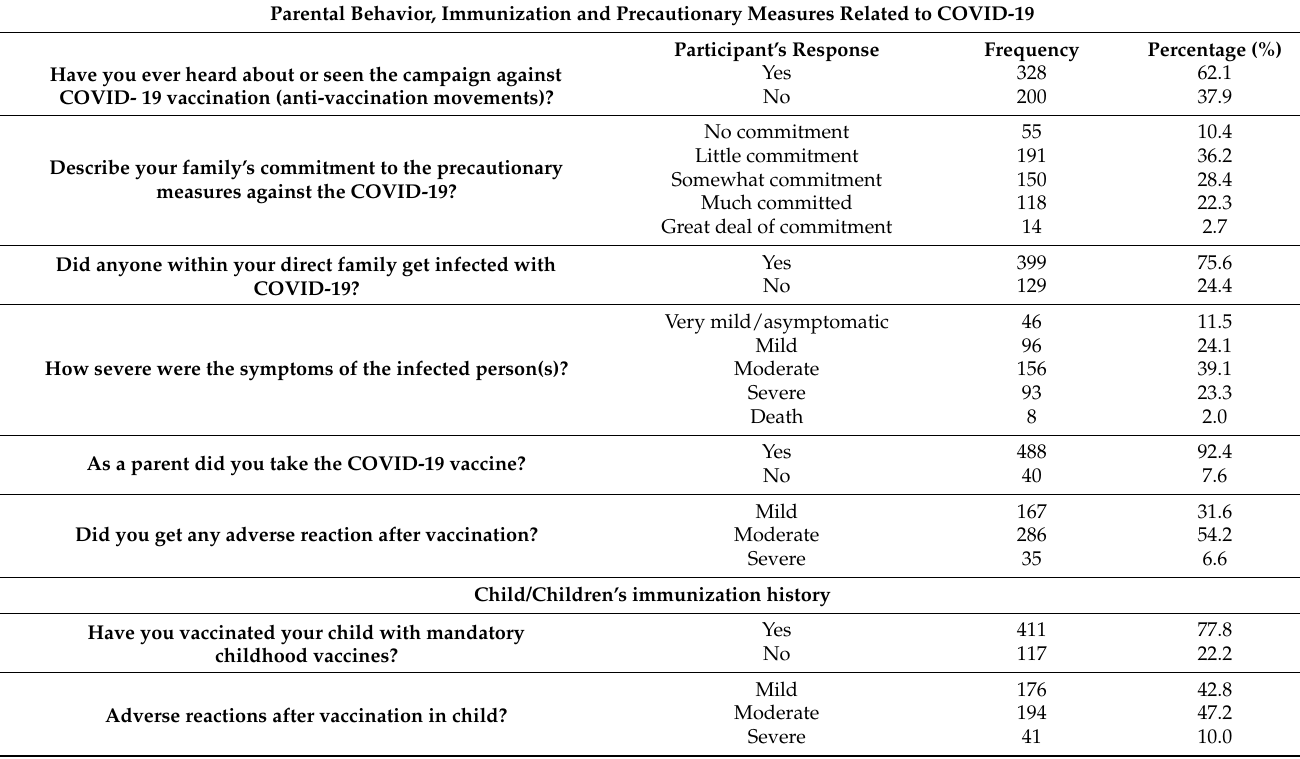
Table 3. Parental behavior, vaccination related to COVID-19 and immunization history of their children. Parental Behavior, Immunization and Precautionary Measures Related to COVID-19